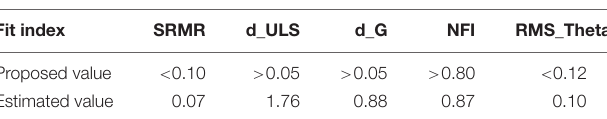
TABLE 6 | Model fit